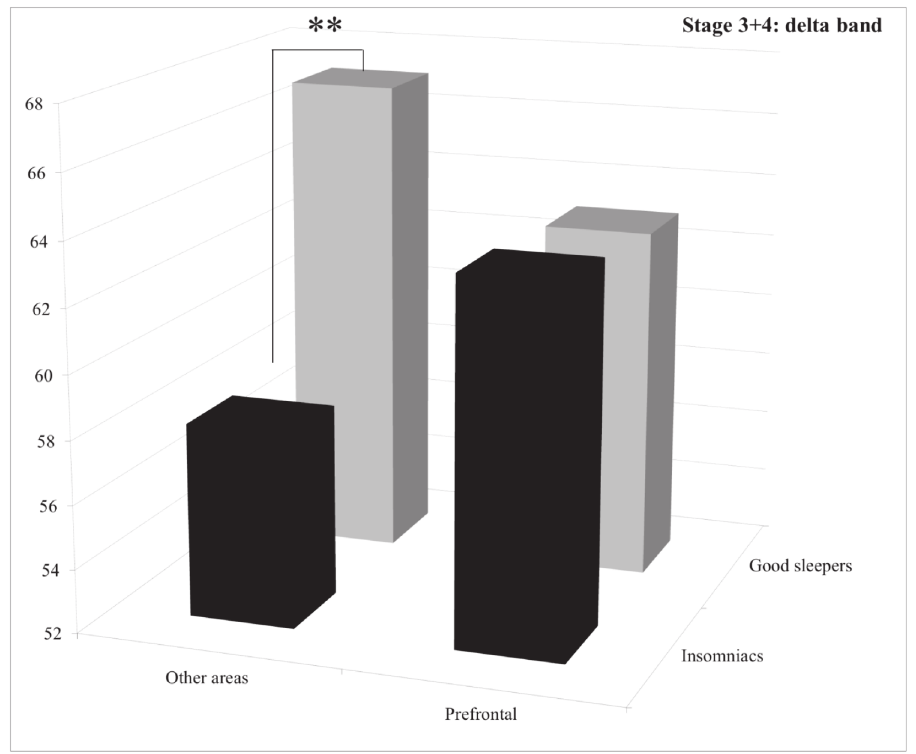
Figure 3. Relative power spectra for the delta band during stage 3+4 for both groups (insomnia patients and good sleepers) and each areas (others vs prefrontal). ** p < 0.05.